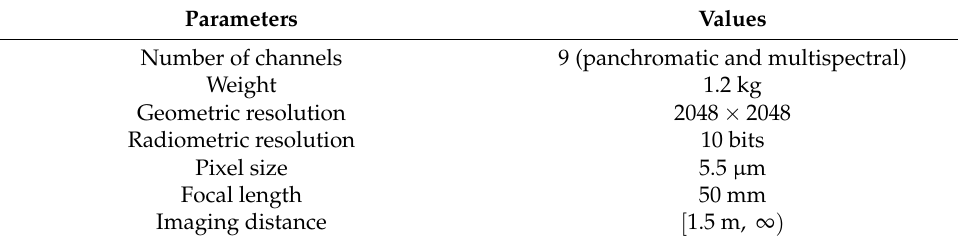
Table 1. Characteristics of the multispectral camera onboard the Zhurong rover.